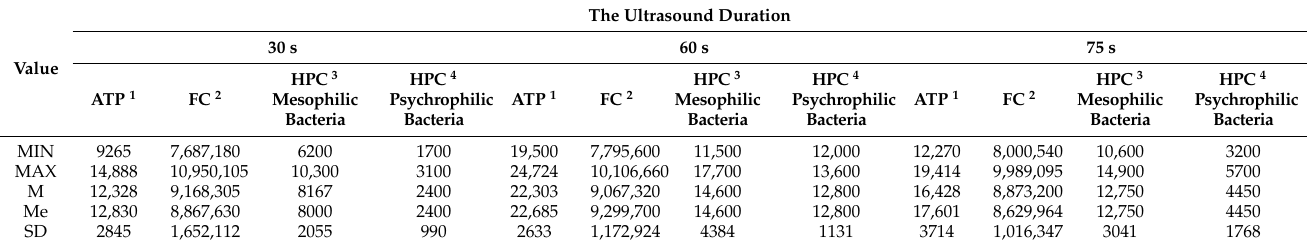
Table 1. Summary of the results f the quantitative analysis of the biofilm depending on the used sonication time (n = 9).